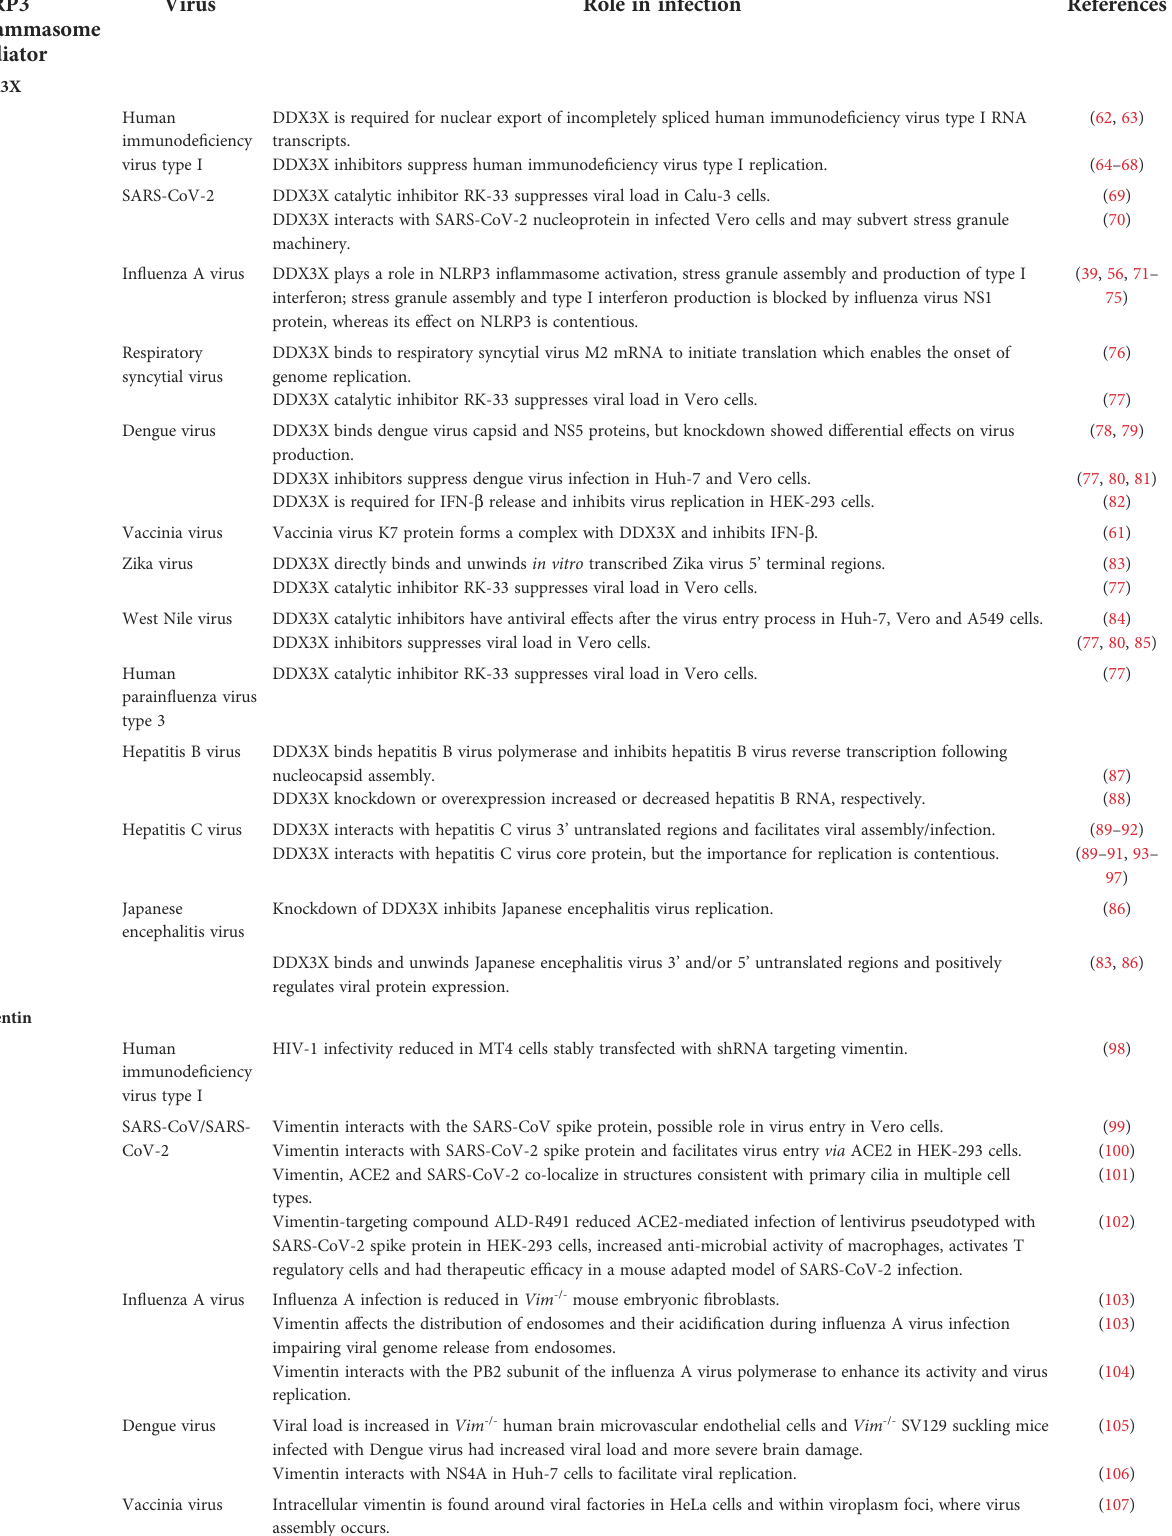
TABLE 1 DDX3X, vimentin and MIF are host proteins with roles in antiviral activity and NLRP3 activation. NLRP3 in fl